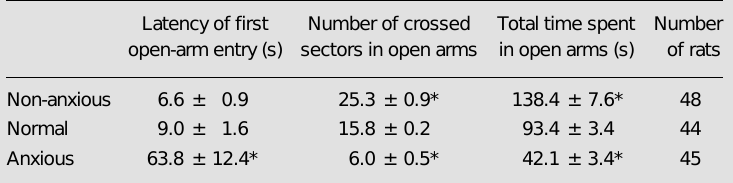
Table 1 - Selection experiment according to the exploratory activity of naive undrugged Wistar rats in an elevated plus-maze. Data are reported as the mean ± SEM. *P £ 0.05 compared to the normal group (one- way ANOVA and Newman-Keuls